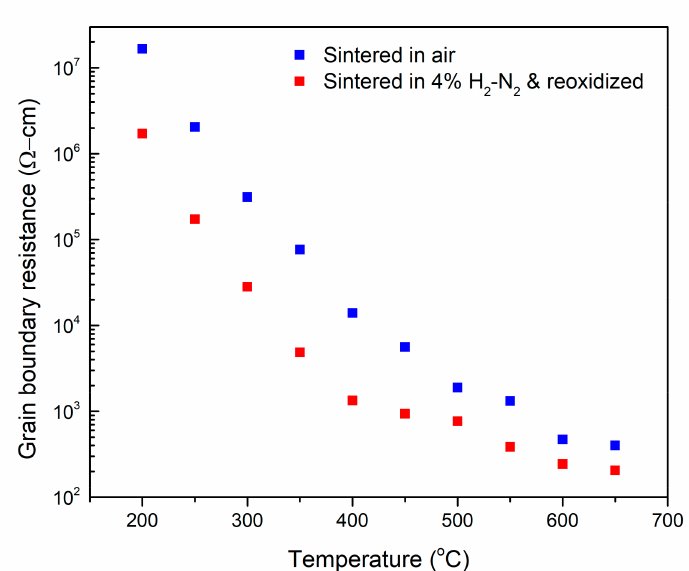
Figure 4. A comparison of the grain boundary resistance with respect to temperature for the control sample and the reduced-reoxidized sample.